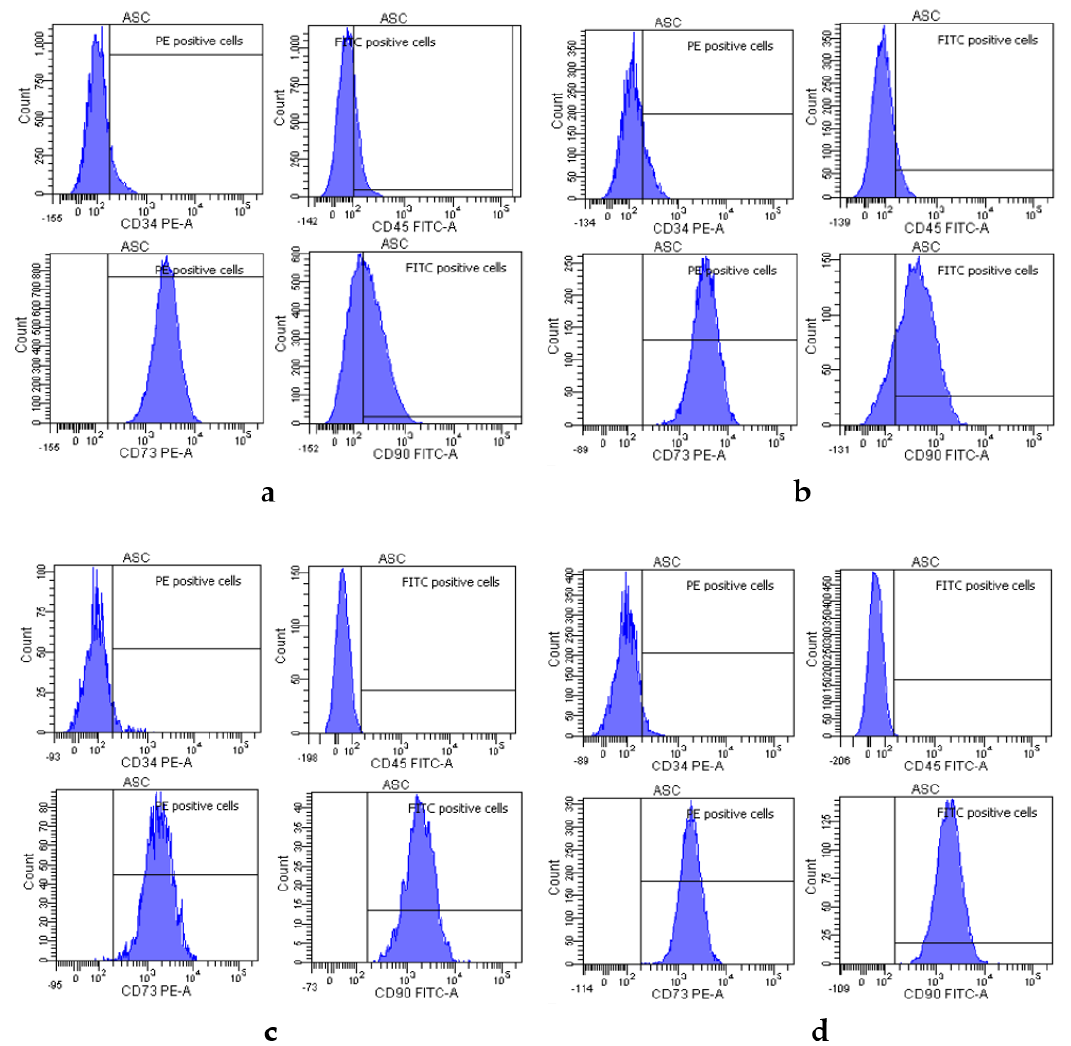
Figure 5. ASC characterization based on surface marker profiles, detected by flow cytometry. ( a ) Immunophenotyping of ASCs encapsulated from donor 16,023 at P3. ( b ) Immunophenotyping of ASCs encapsulated from donor 17,149 at P3. ( c ) Immunophenotyping of monolayer ASCs from donor 16,023 at P3. ( d ) Immunophenotyping of monolayer ASCs from donor 17,149 at P3.